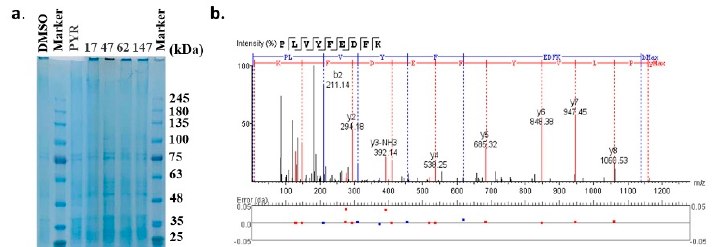
Figure 5. Proteinligand interactions of candidate compounds with Pf PMV. ( a – d ) illustrate the binding of residues with compounds 17 , 47 , 62 and 147 . Candidate compounds were shown in green color. S1, S2 and S3 represent three subpockets. Dashed line in red indicates H-bonds interactions, grey represents t hydrophobic interaction, yellow illustrates pi–pi interaction and blue implies halogen bond interaction.